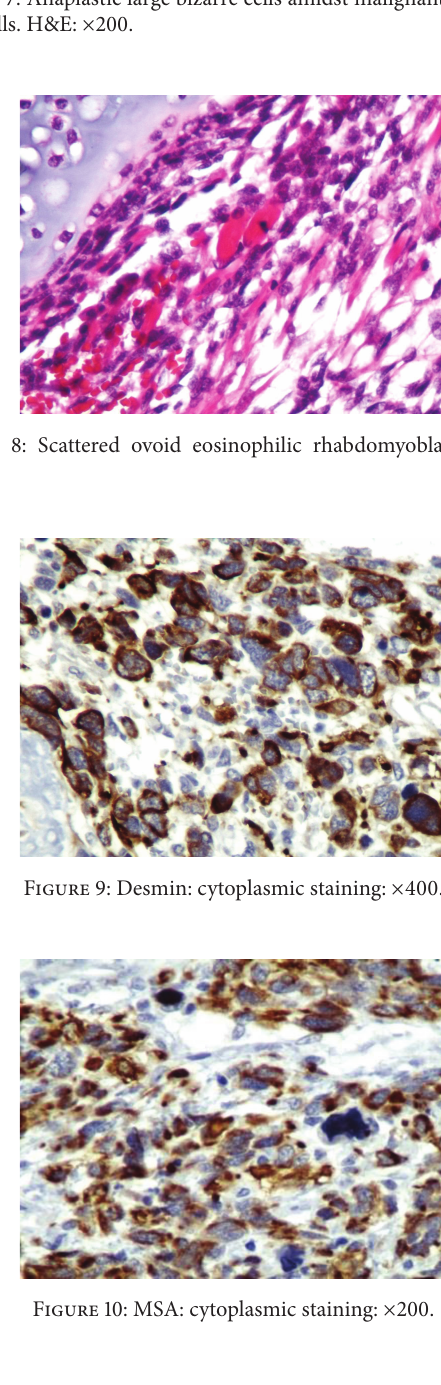
Figure 11: S100: nuclear staining in cartilage tissue: × 200.